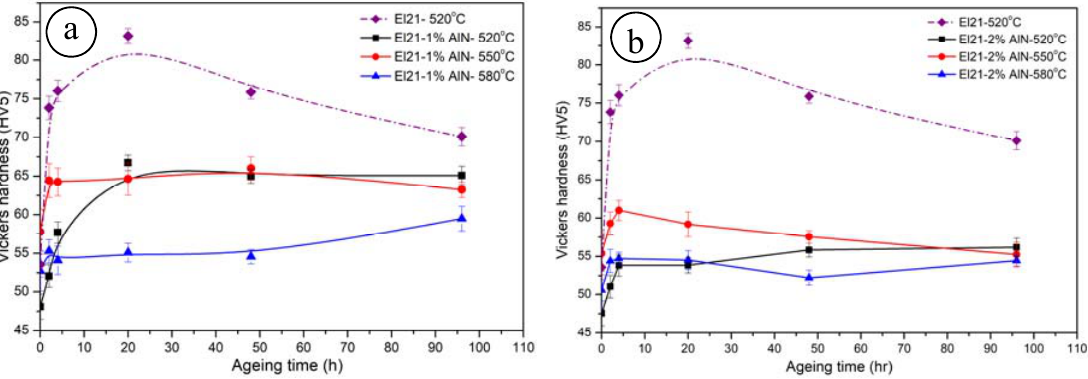
Figure 18. Hardness variation of: ( a ) El21–1.0 wt.% AlN; and ( b ) El21–2.0 wt.% AlN solutionized at 520 °C, 550 °C and 580 °C then aged at 200 °C for various periods.